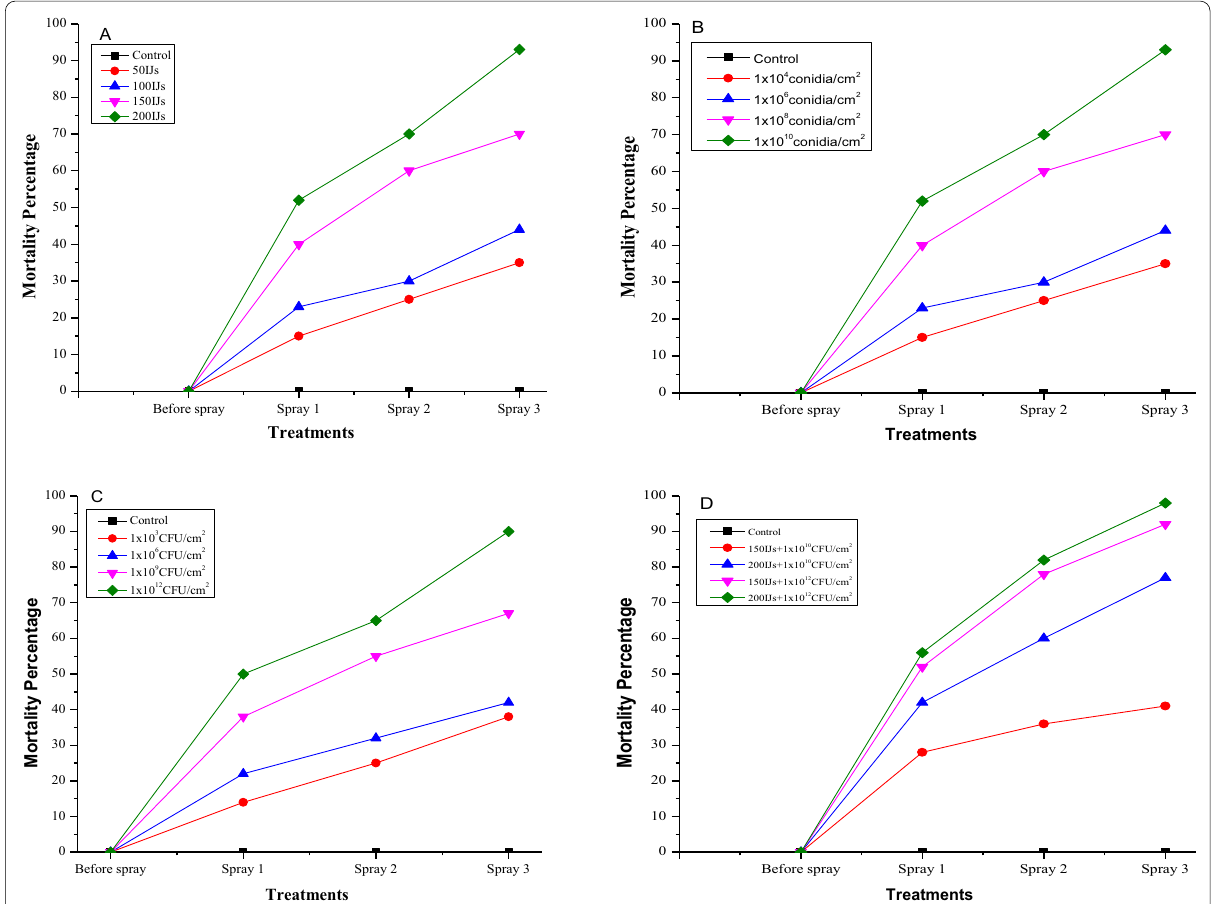
Fig. 3 Application of entomopathogens on larval mortality in capsicum plants against Spodoptera litura (3rd instar) As: A Heterorhabditis bacteriophora , B Beauveria bassiana , C Bacillus thuringiensis , D H. bacteriophora